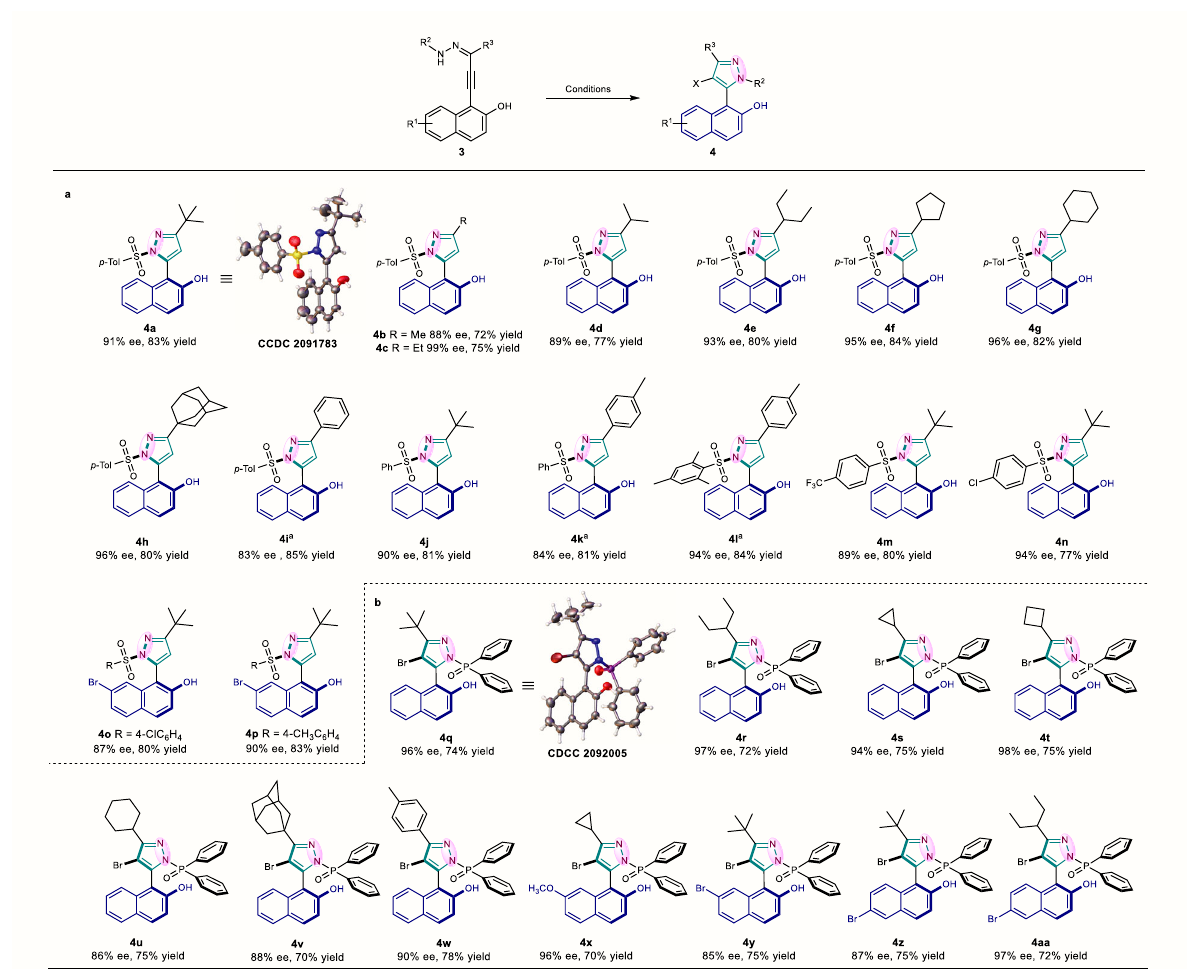
Fig. 4 Substrate scope of naphthyl-pyrazoles. a Reaction conditions: 3a – 3p (0.1 mmol), C (10 mol %) in DCM (4.0 mL) at 25 °C for 12 h; a Reaction time was extended to 24 h. b Reaction conditions: 3q – 3aa (0.1 mmol), E (20 mol %), NBS (0.105 mmol) in toluene (2.0 mL) at 25 °C for 1 h; Enantiomeric excess (ee) were determined by HPLC; Isolated